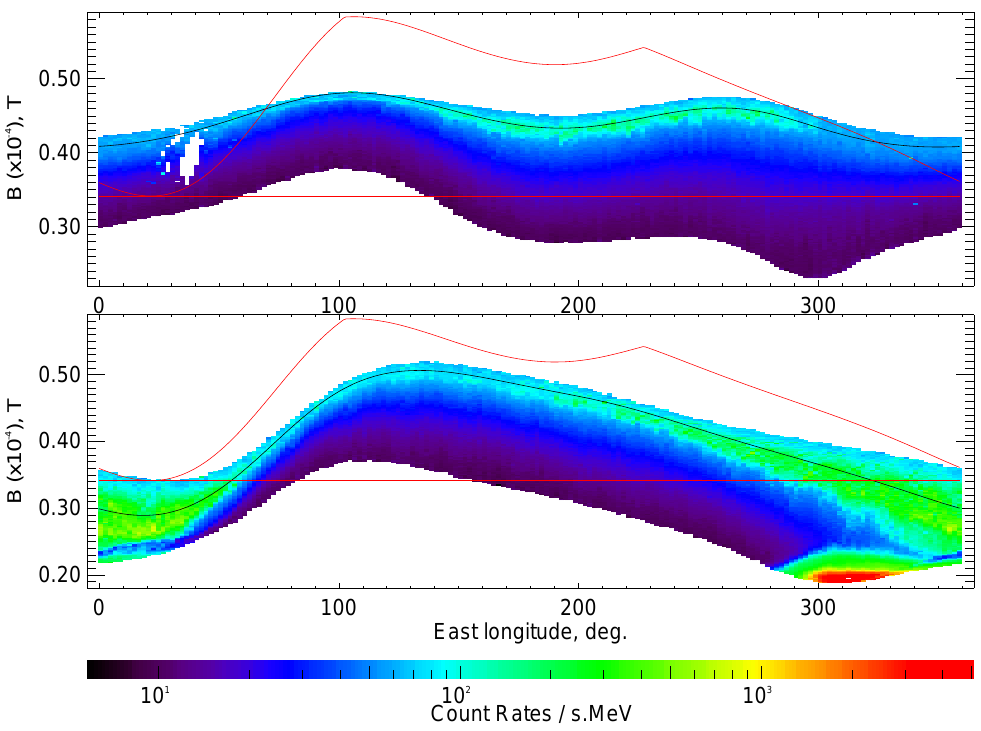
Fig. 9. The longitude distribution of 3 − 8 . 3MeV CORONAS-I gamma rays at Northern (top) and Southern (bottom) Hemispheres for L -shells between 1.2 and 6. The black line indicates L = 3 . 9 at 500km altitude, and atmospheric loss cones at L = 3 . 9 are illustrated by the red